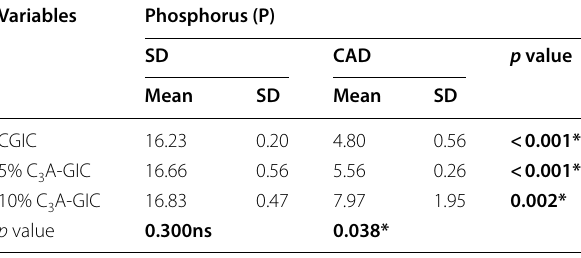
Table 3 The mean, standard deviation (SD) values of Phosphorus of different